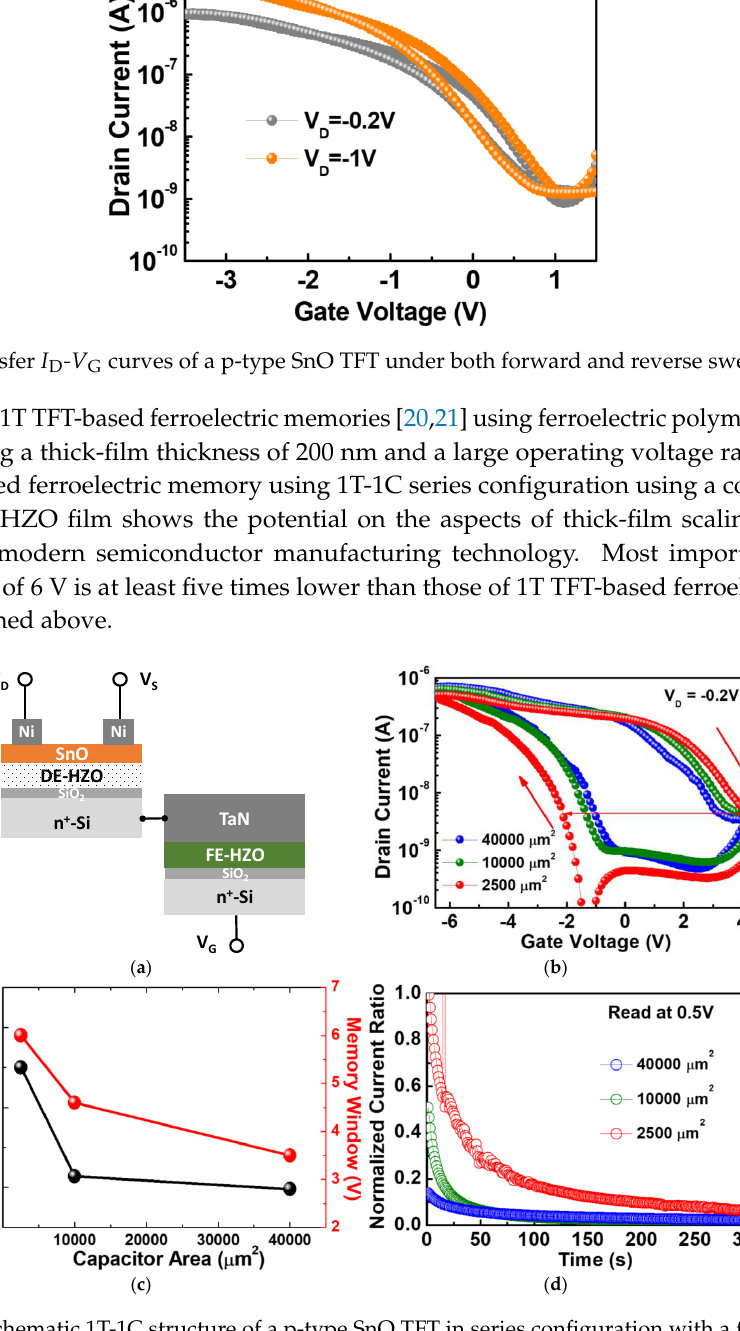
Figure 6. ( a ) Schematic 1T-1C structure of a p-type SnO TFT in series configuration with a ferroelectric HZO capacitor; ( b ) transfer I D - V G curves of the 1T-1C TFT structure of the p-type SnO TFT integrated with the ferroelectric HZO MFM capacitor; ( c ) extracted memory window and I ON / I OFF ratio at V G = −0.2 V as a function of the ferroelectric capacitor area; ( d ) normalized current ratio as a function of reading time for p-type SnO TFT in series configuration with different HZO MFM capacitor areas.